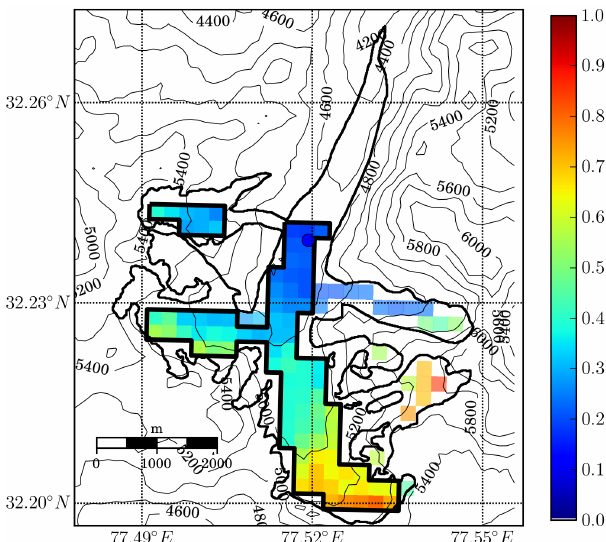
Figure 2. Example of an albedo map retrieved by MODImLab over Chhota Shigri Glacier on 7 September 2001 05:50:00 (UTC). The bold line delimits the pixels used to average the albedo ( n = 89, cor- responding to 4.875km 2 ). The northern lower part of the glacier is covered with debris and the tributaries exhibit surfaces that include many rock outcrops. The blue dot shows the location of the AWS.